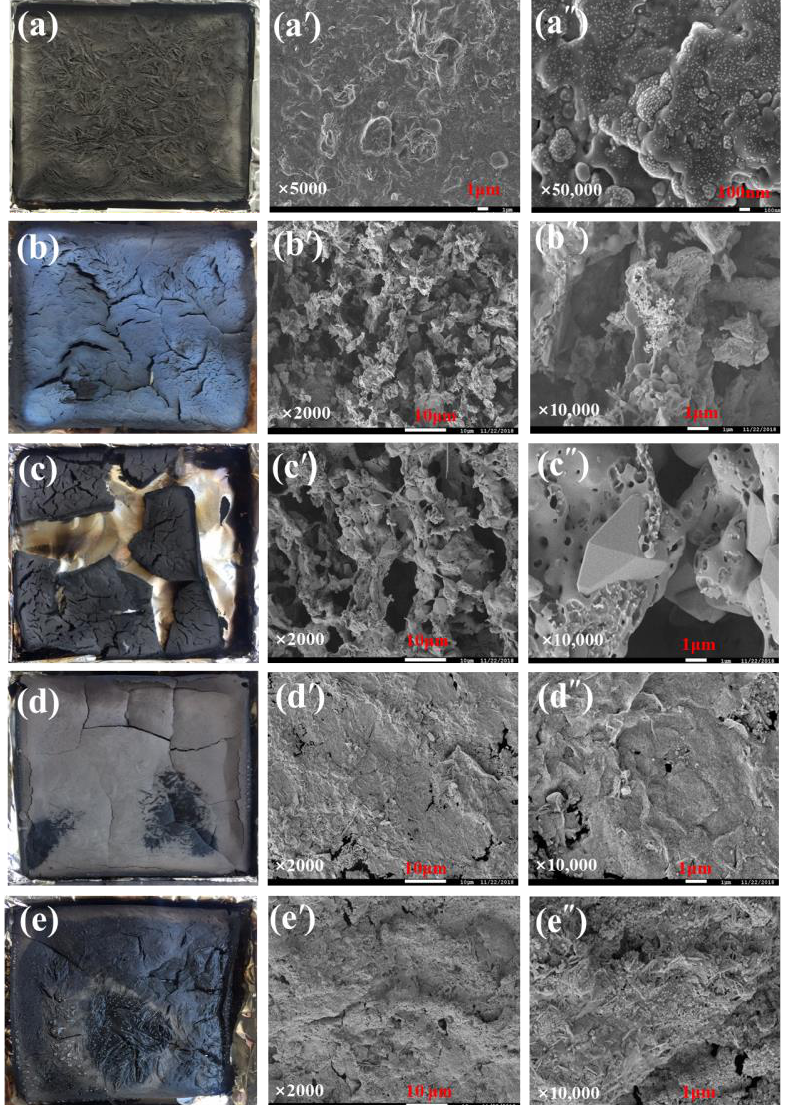
Figure 6. Digital photographs ( a – e ) and SEM ( a′ – e′ , a ″ – e″ ) images of the residues for the PAM com- posite aerogels after cone calorimeter test. ( a , a′ , a″ ) PAM; ( b , b′ , b″ ) PAM/Ms; ( c , c′ , c″ ) PAM/MsCa; ( d , d′ , d″ ) PAM/K; ( e , e′ , e″ ) PAM/KCa.